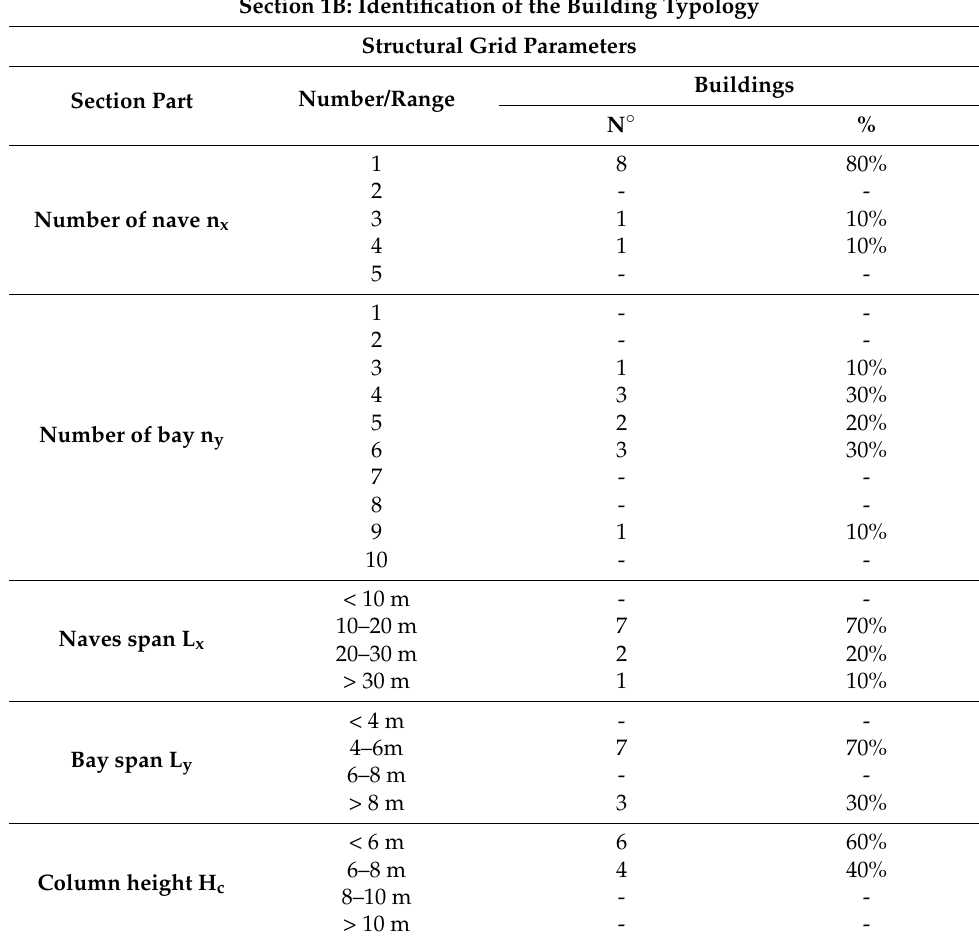
Table 4. Section 1B CARTIS-Building. Case studies characterization: Identification of the building